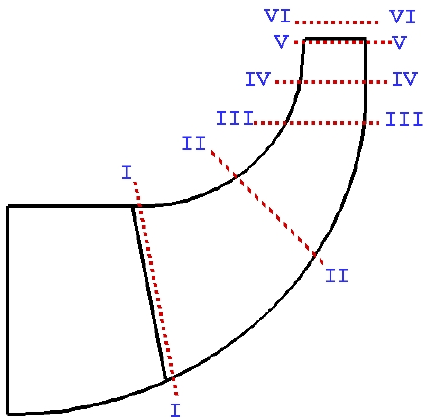
Figure 15. Illustration of different meridional sections within the impellers.